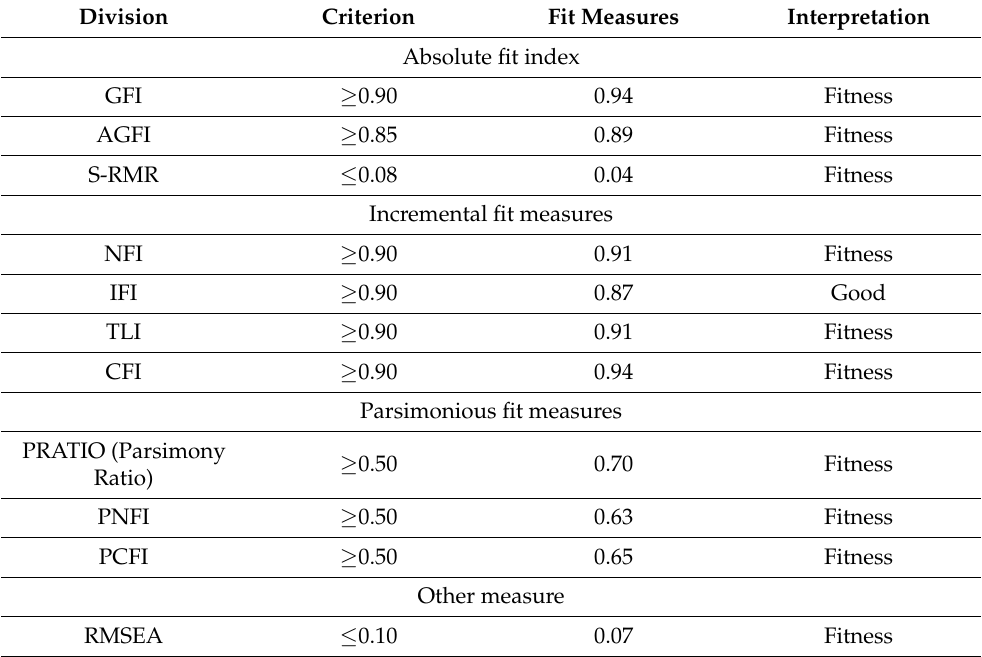
Table 4. Fitness index of the measurement